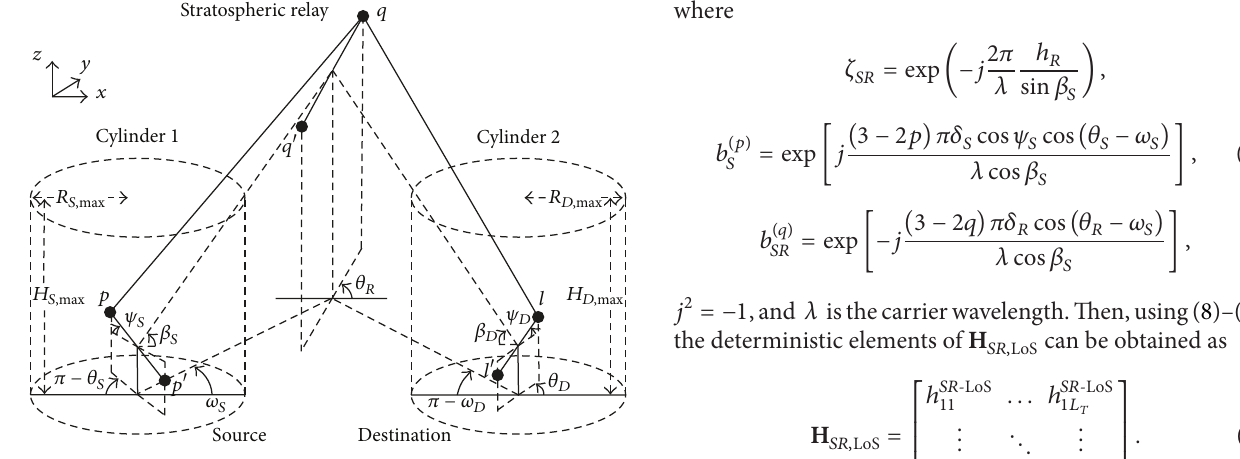
Figure 2: LoS paths of the 3D model for a 2 × 2 × 2 MIMO MMSR channel.